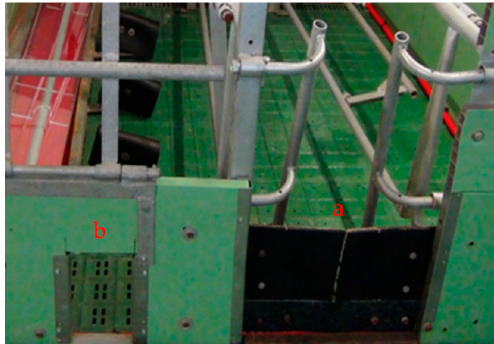
Figure 2. Farrowing pen with flexible steps at the entrance ( a ) and closable apertures in the pens’ board ( b ) to prevent the piglets from leaving the pens during the first post-partum days (Photo: